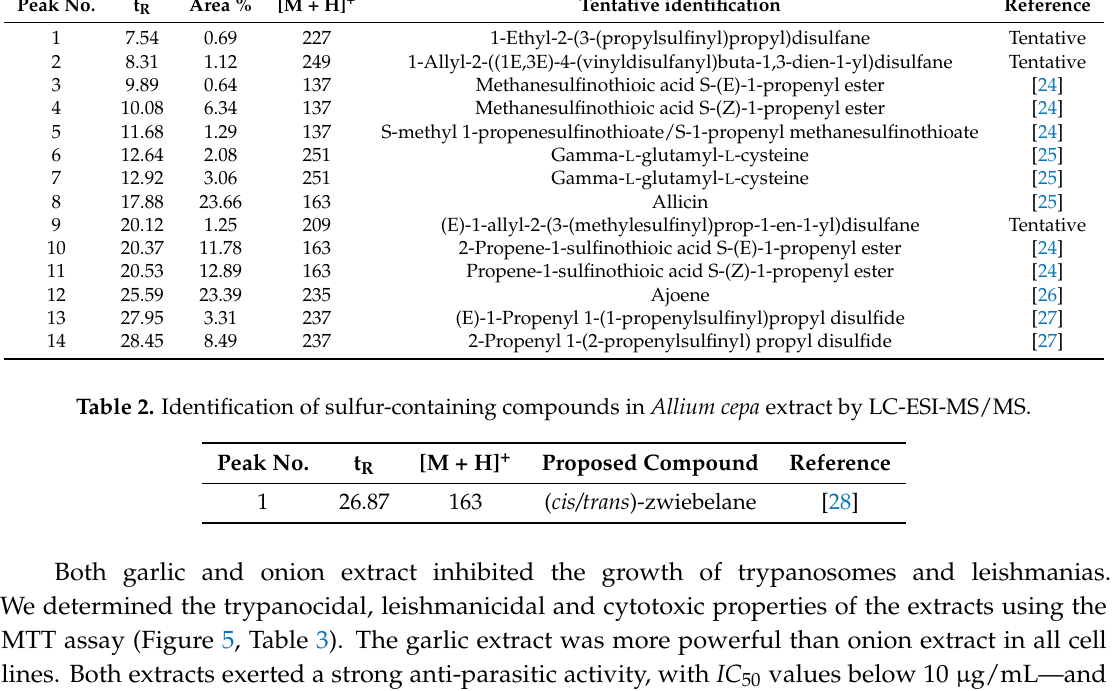
Table 1. Identification of sulfur-containing compounds in Allium sativum extract by LC-ESI-MS/MS. Peak No. Peak No.